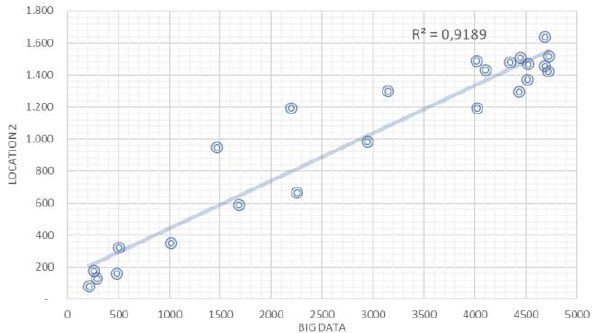
Figure 6 . Correlation analysis - daily unevenness of traffic flow (a characteristic day of the